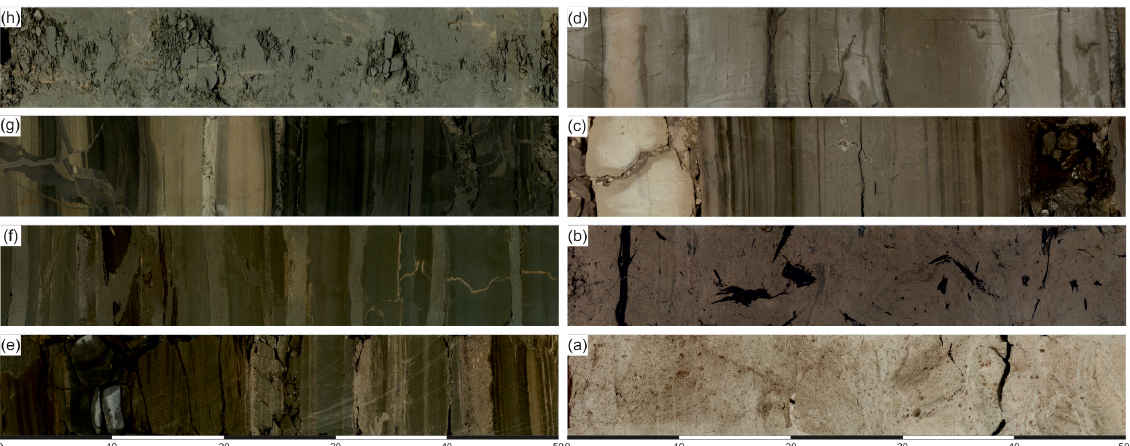
Figure 9. Representative lithologies in core HJB-1. (a) Palaeozoic schists with siderite concretions (104.16–104.66m); (b) sandy mudstone with lignite coal (79.50–80.00m); (c) interbedded sandy mudstones, calcareous mudstones and carbonates (78.50–79.00m); (d) calcareous mudstones with gypsum layers and injection structures (77.61–78.11m); (e) interbedded laminated mudstones and peloidal to bioclastic carbonates (69.56–70.06m); (f) “false bedded” mudstones (light colored regular banding represents injected drilling mud) with natural injection structures (64.55–65.05m); (g) laminated mudstones with natural deformation structures and “false bedding” ( ∼ 42.00–42.46m and (h) massive mudstones ( ∼ 35.15–35.60m). Scale is in centimeters.